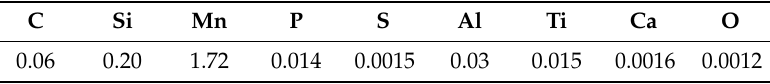
Table 1. Chemical composition of the alloy used in this study